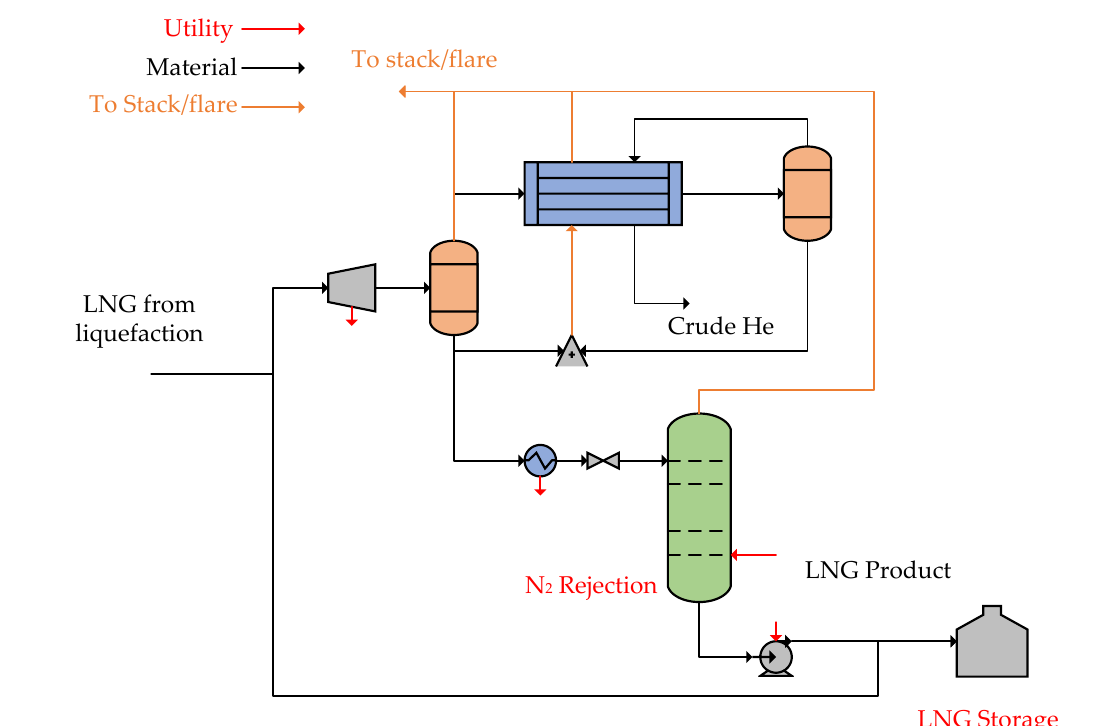
Figure 10. PFD of the simulated HeX and NR unit. The fractionating unit consists mainly of three conventional distilling columns. One of them is the de-ethanizing column (C-21), one is the de-propanizer (C-22), and the other is the de-butanizer (C-23), as indicated by Figure 11. The conditions and specifications of this unit are illustrated in Table 10. The liquefied petroleum gas (LPG) is sent back to liquefaction to be mixed with LNG.